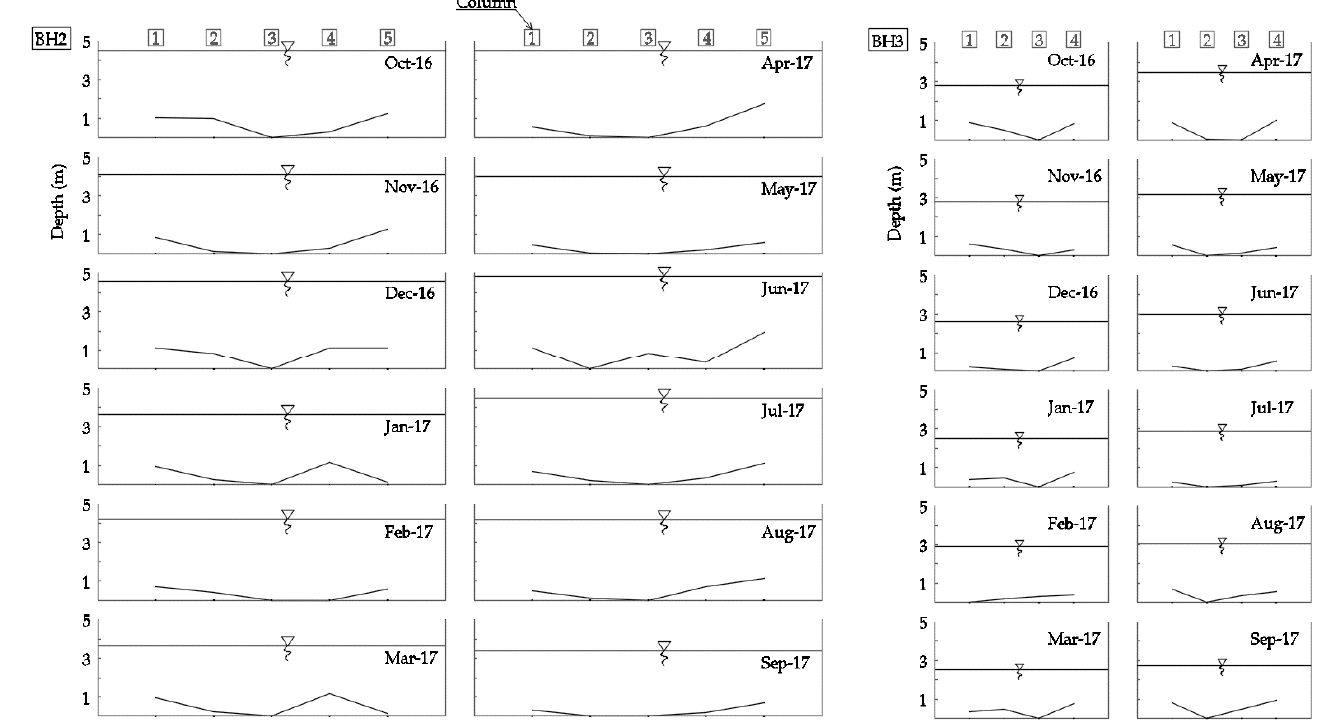
Figure 11. Cross-section of BH2 and BH3 with variations of the water depth on each column.